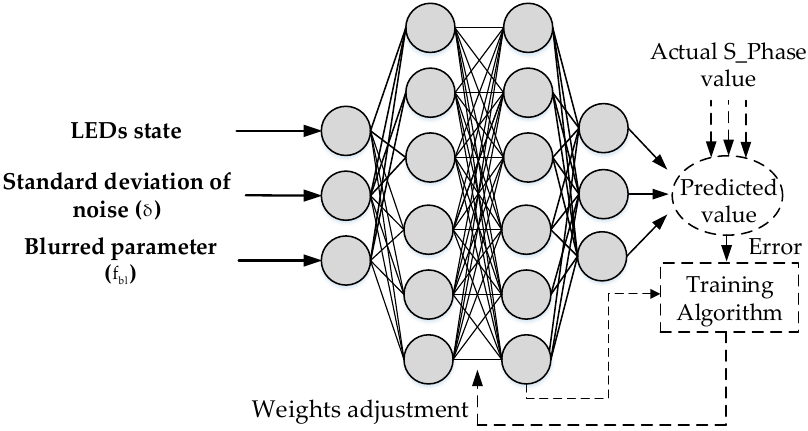
Figure 7. The principle of training a neural network (NN)-based decoder for blurry and noisy data.